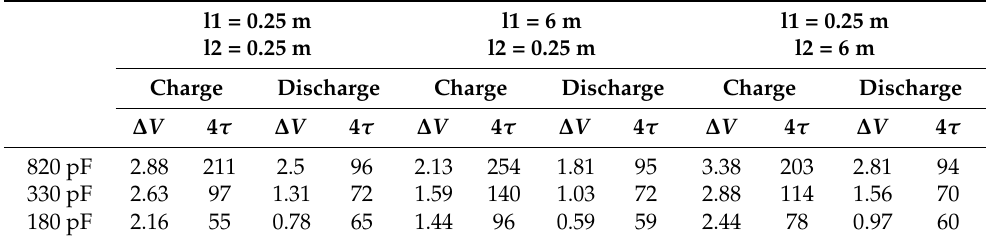
Table 4. Measurement result for the 3-Switches